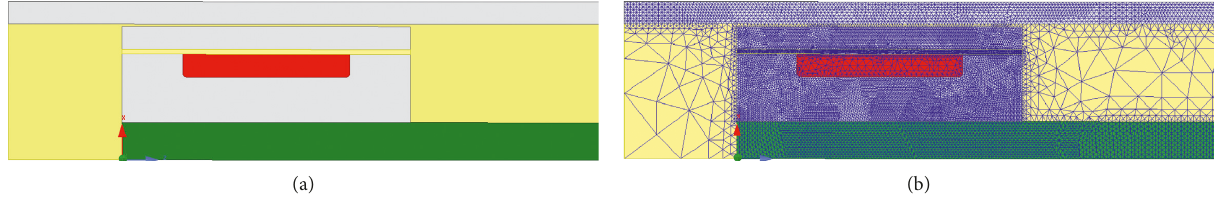
Figure 5: Simplified geometry of the piston unit and mesh. (a) Geometry. (b)